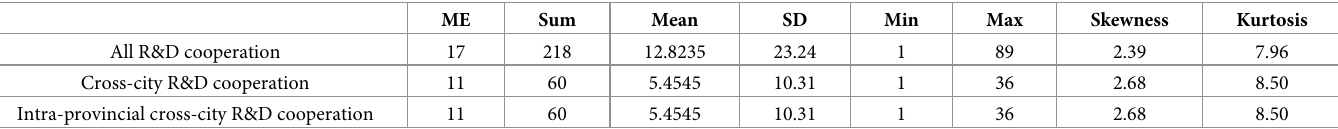
Table 9. Descriptive statistics of the Pearl River Delta 2011–2013.